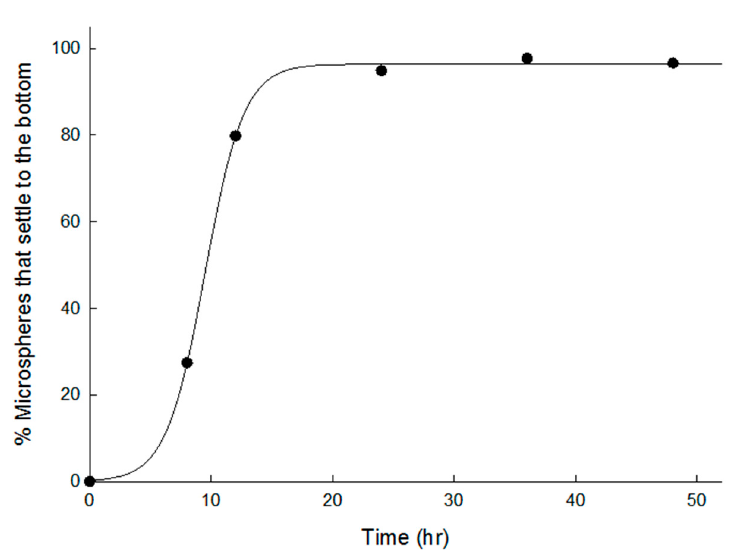
Figure 6. Sedimentation rates of dried microspheres prepared using 7 mL of the ammonia solution. They were dispersed in 0.2% Tween 80 solution at RT, and the amounts of their sediments were determined over time.